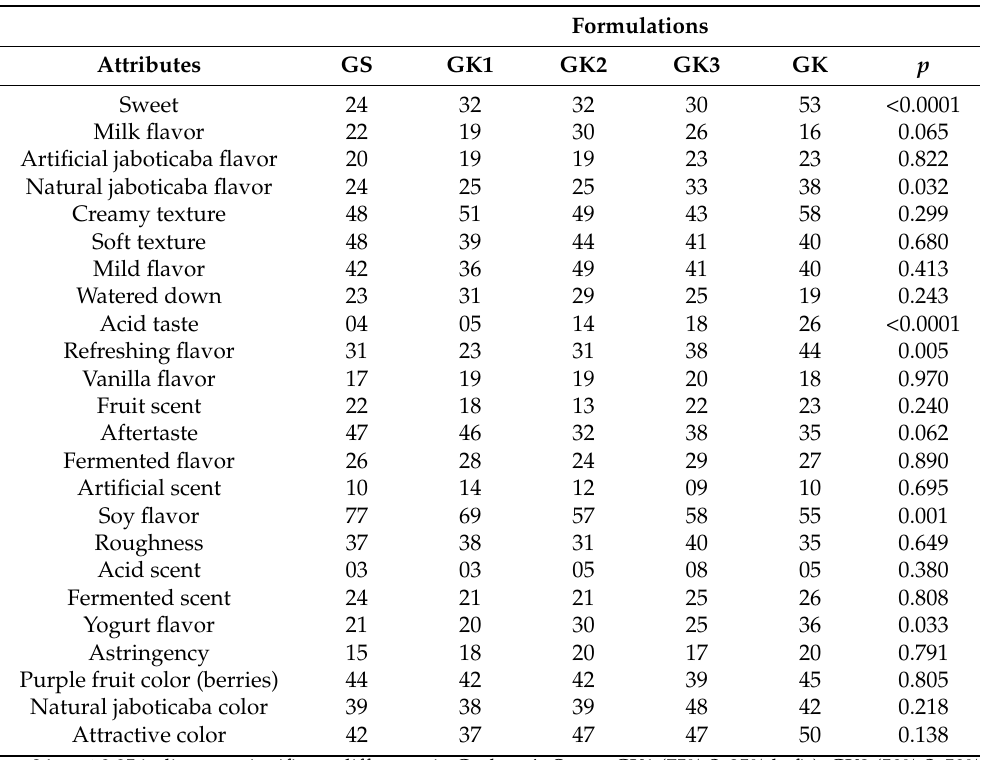
Table 8. Frequency of sensory attributes and Cochran’s Q test associated with each ice cream at the beginning of the storage period